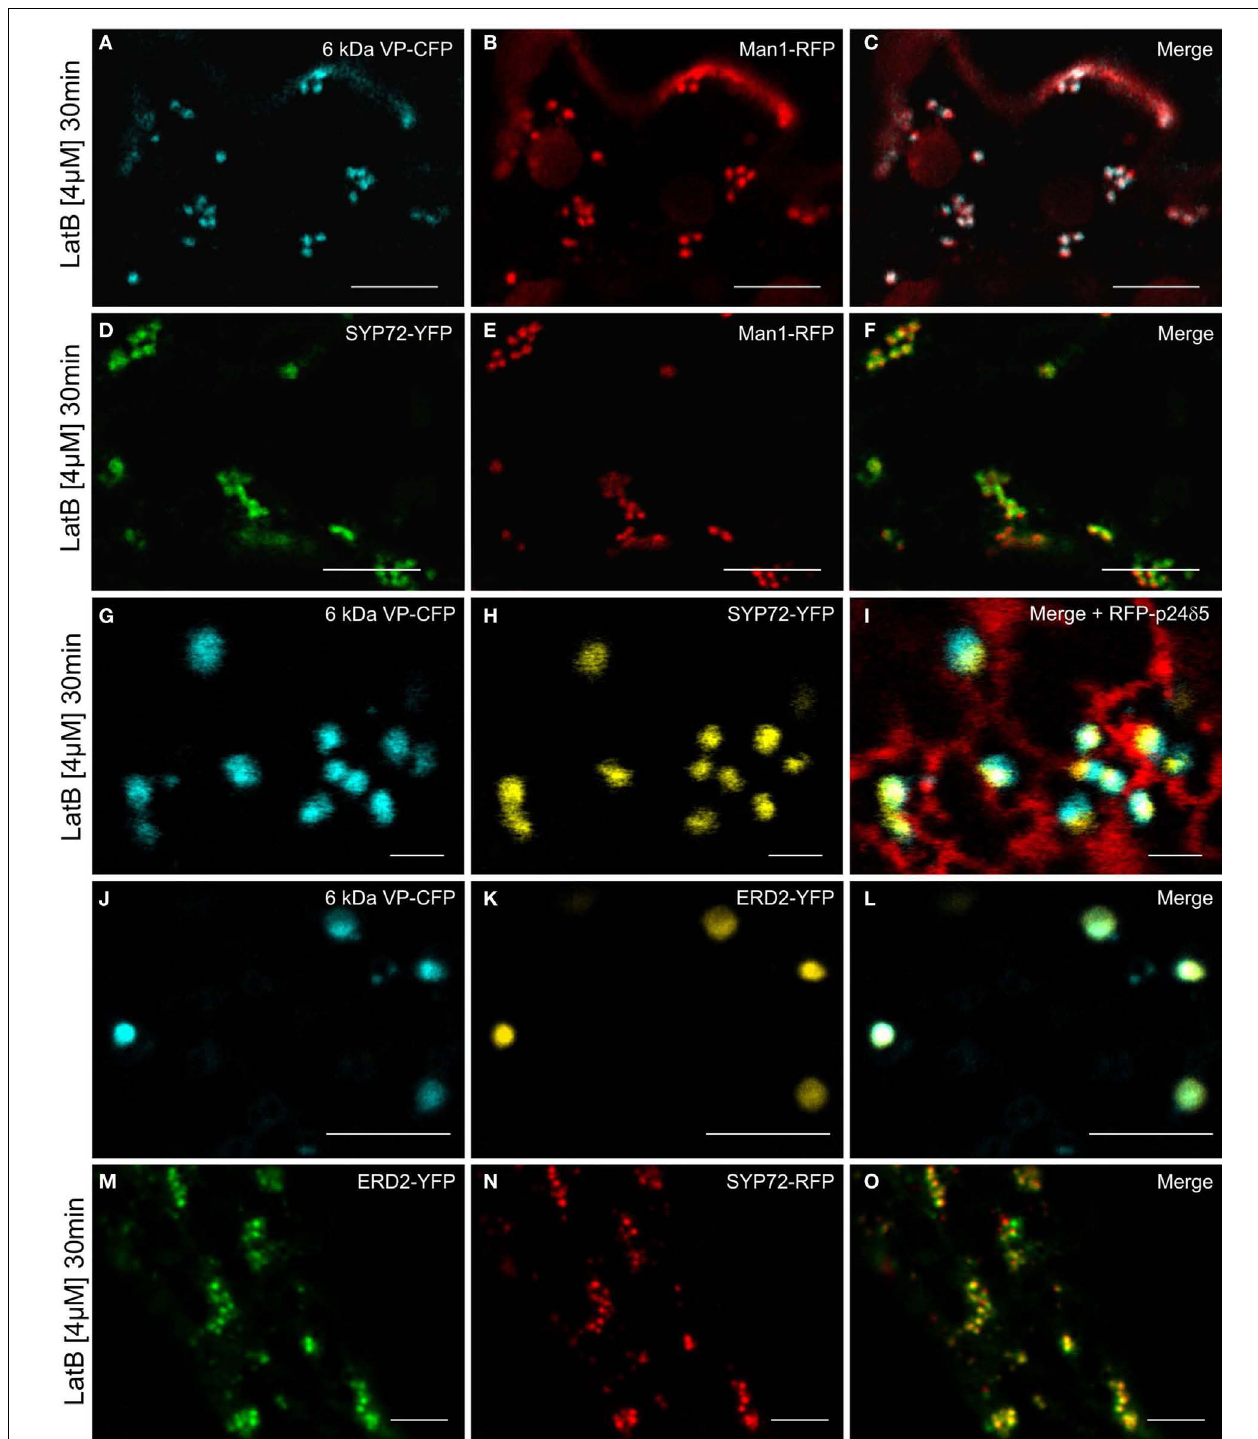
untreated cells (J–L) and ERD2-YFP and SYP72-RFP fluorescence after latrunculin B treatment (M–O) . Segments of the agroinfiltrated leaves were cut out 2days post-infiltration and incubated for 30min with latrunculin B (4 µ M) before observation in the CLSM. Magnification bars = 10 µ m (A–F) ; 1 µ m (G–I) ; 5 µ m (J–O)